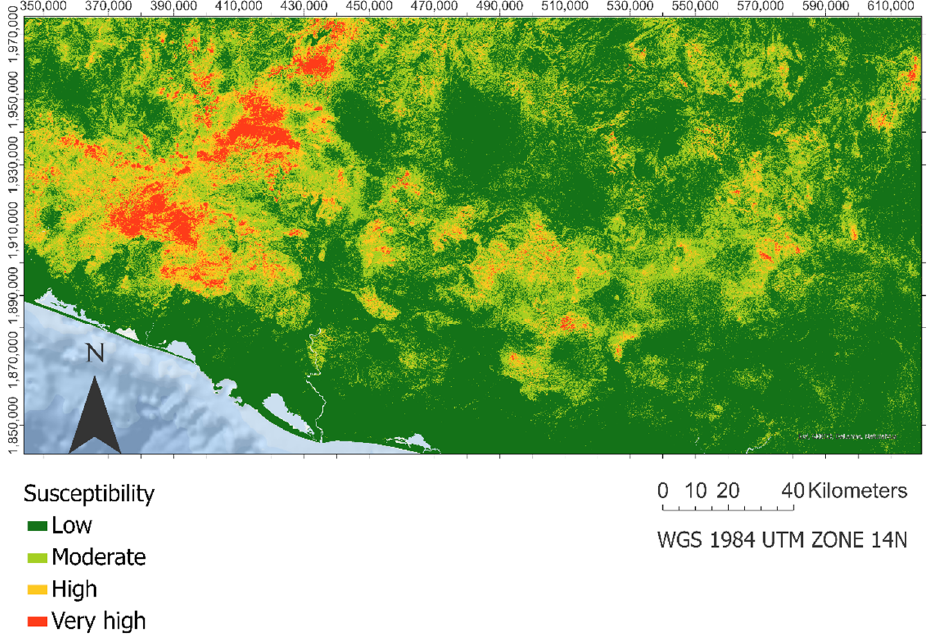
Figure 2. Landslide susceptibility map based on the probabilistic prediction of the extra trees